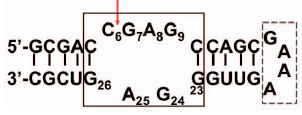
Figure 1 Secondary structure of the leadzyme. The box region is the active site, and the red arrow indicates the scissile bond. The GAAA tetraloop in the dashed box is sometimes used to render the construct